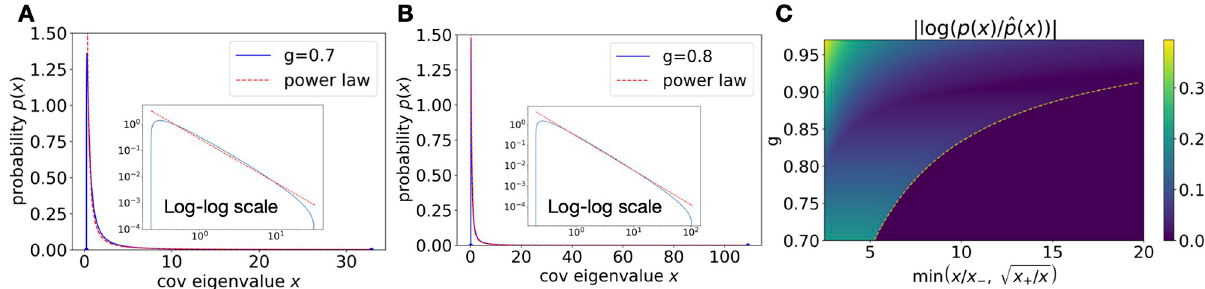
Fig 2. Approximate power-law tail. A . The exact pdf (solid line) of the covariance spectrum compared with the power-law approximation (dashed line, Eq (7)) at g = 0.7. Inset shows the log-log scale. B . Same as A. for g = 0.8. The approximation improves as g approaches the critical value 1. C . The log error between the exact pdf and approximation j log ð p ð x ÞÞ (cid:0) log ð ^ p ð x ÞÞj as a function of g and “distance” from the support edges. We quantify this ffiffiffiffiffiffiffiffiffiffi p and (more details and motivations in Section A.2 in S1 Text. The plot shows the log error is small when “distance” as the minimum ratio of x / x x þ = x − this ratio is large, which means x being far away from the edges. The dashed line shows the attainable region of the ratio which increases with g .